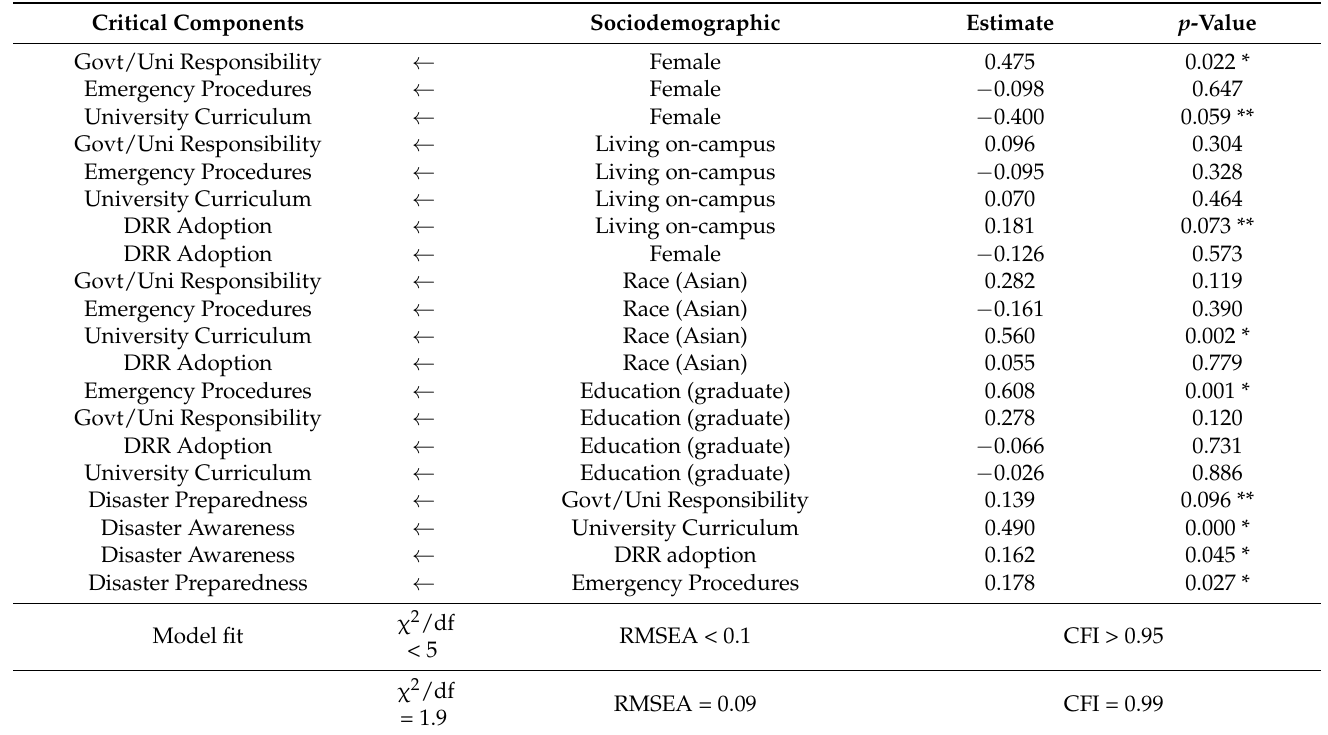
Table 5. Direct effects given in standardized